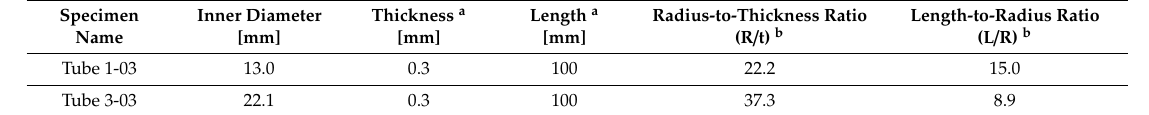
Table 2. Dimensions of the two tube columns tested in this study.